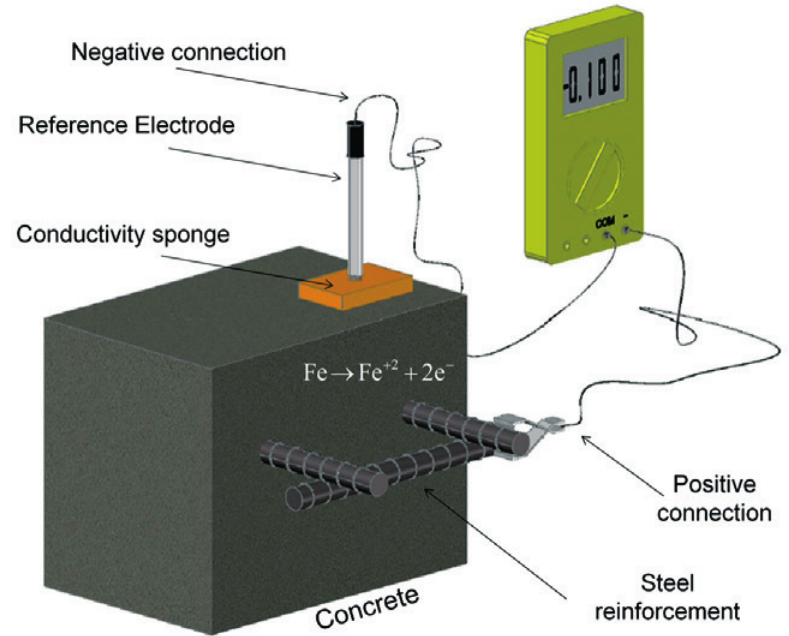
Configuration of circuit for determination of corrosion potential (ASTM C 876:2009 [18] adapted by ROCHA